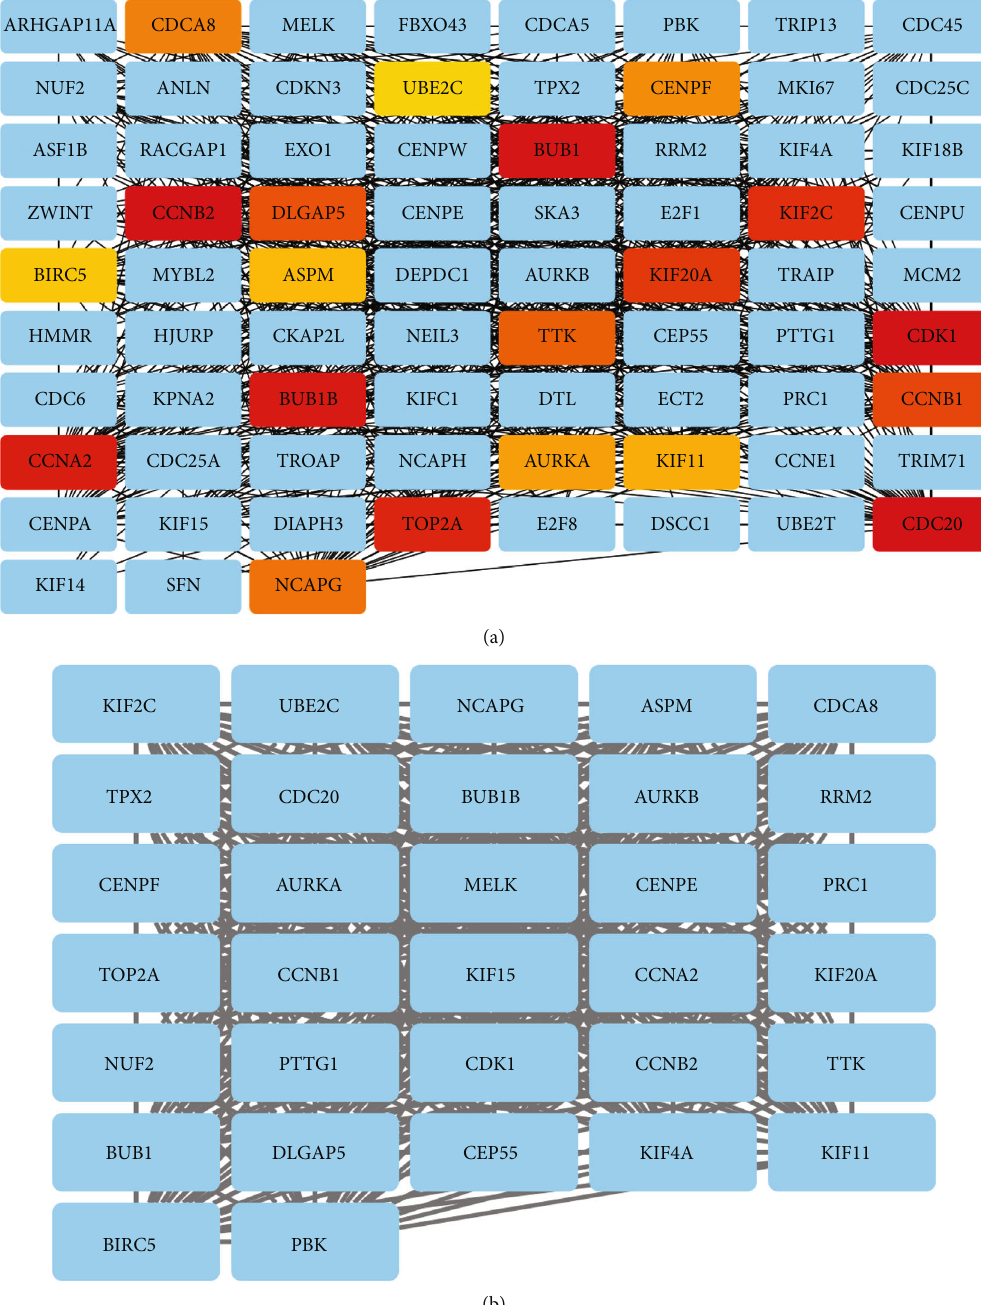
Figure 4: PPI network analysis of DEGs. (a) PPI network constructed by using CytoHubba. (b) PPI network established by